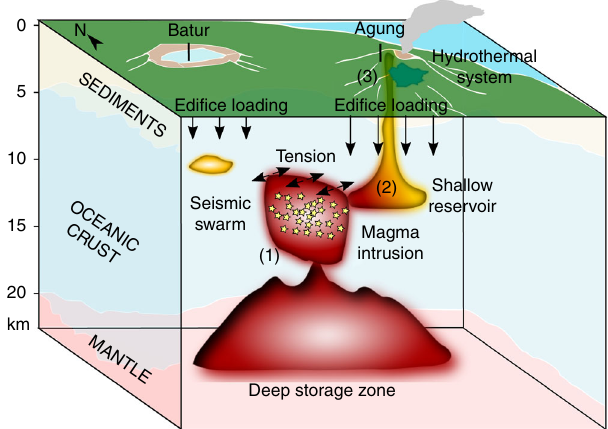
Fig. 7 Conceptual model of the magmatic systems below Agung and Batur volcanoes. The model is based on geophysical observations from 2017 and petrological studies of previous eruptions 18,19,54 . The numbers 1 – 3 indicate the different processes that occurred prior to the 2017 eruption: (1) the emplacement of a magma intrusion between Agung and Batur, which induced seismicity and ground deformation; (2) mixing between ma fi c magma from the intrusion and a more differentiated magma in a pre- existing shallow reservoir; (3) ascent of the mixed magma causing pressurization of the hydrothermal system and initiation of the